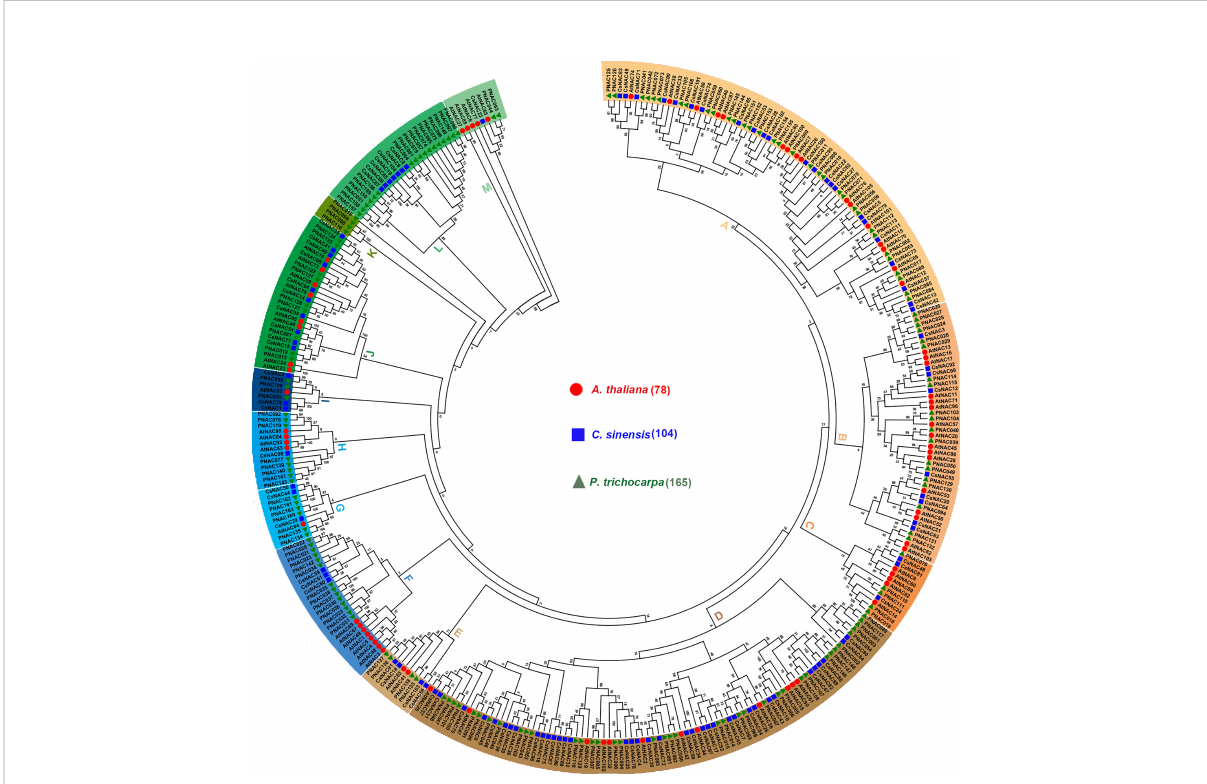
FIGURE 1 Phylogenetic tree of NACs from Arabidopsis thaliana , Populus trichocarpa and C. sinensis . Amino acid sequences were aligned using Clustal X software and subjected to phylogenetic analysis using MEGA X software by the NJ method with 1,000 bootstrap